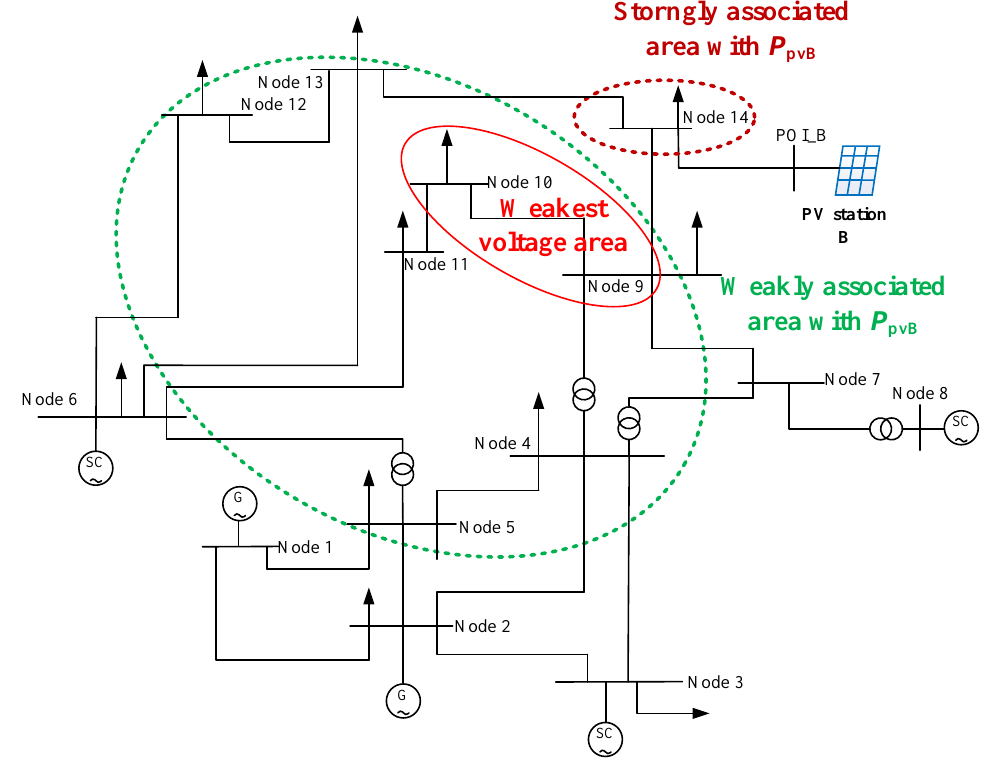
Figure 8. Static voltage stability zoning chart of Plan B.